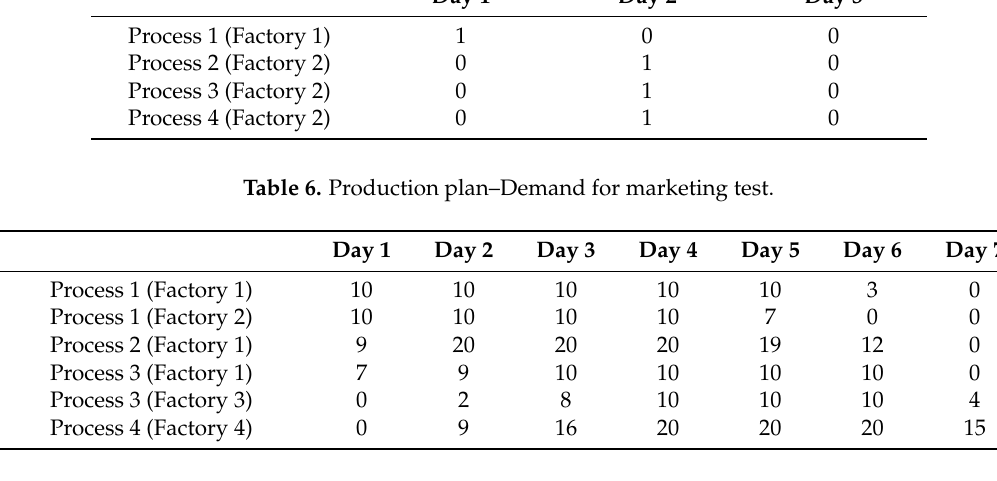
Figure 5. Cost comparison based on change in problem size.